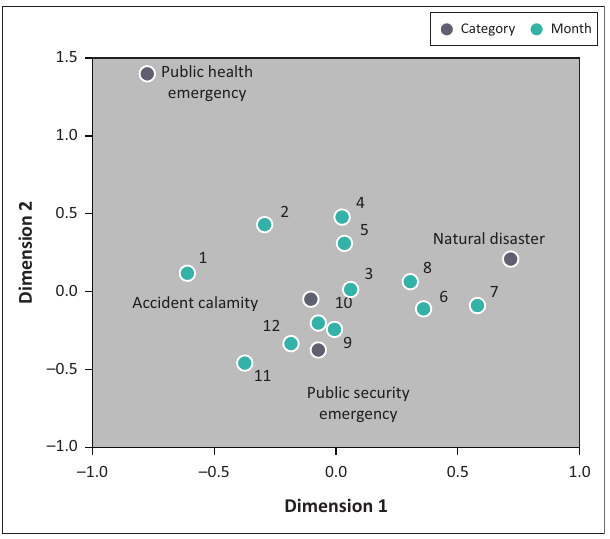
FIGURE 6: ‘Time–event’ correspondence analysis of emergencies.